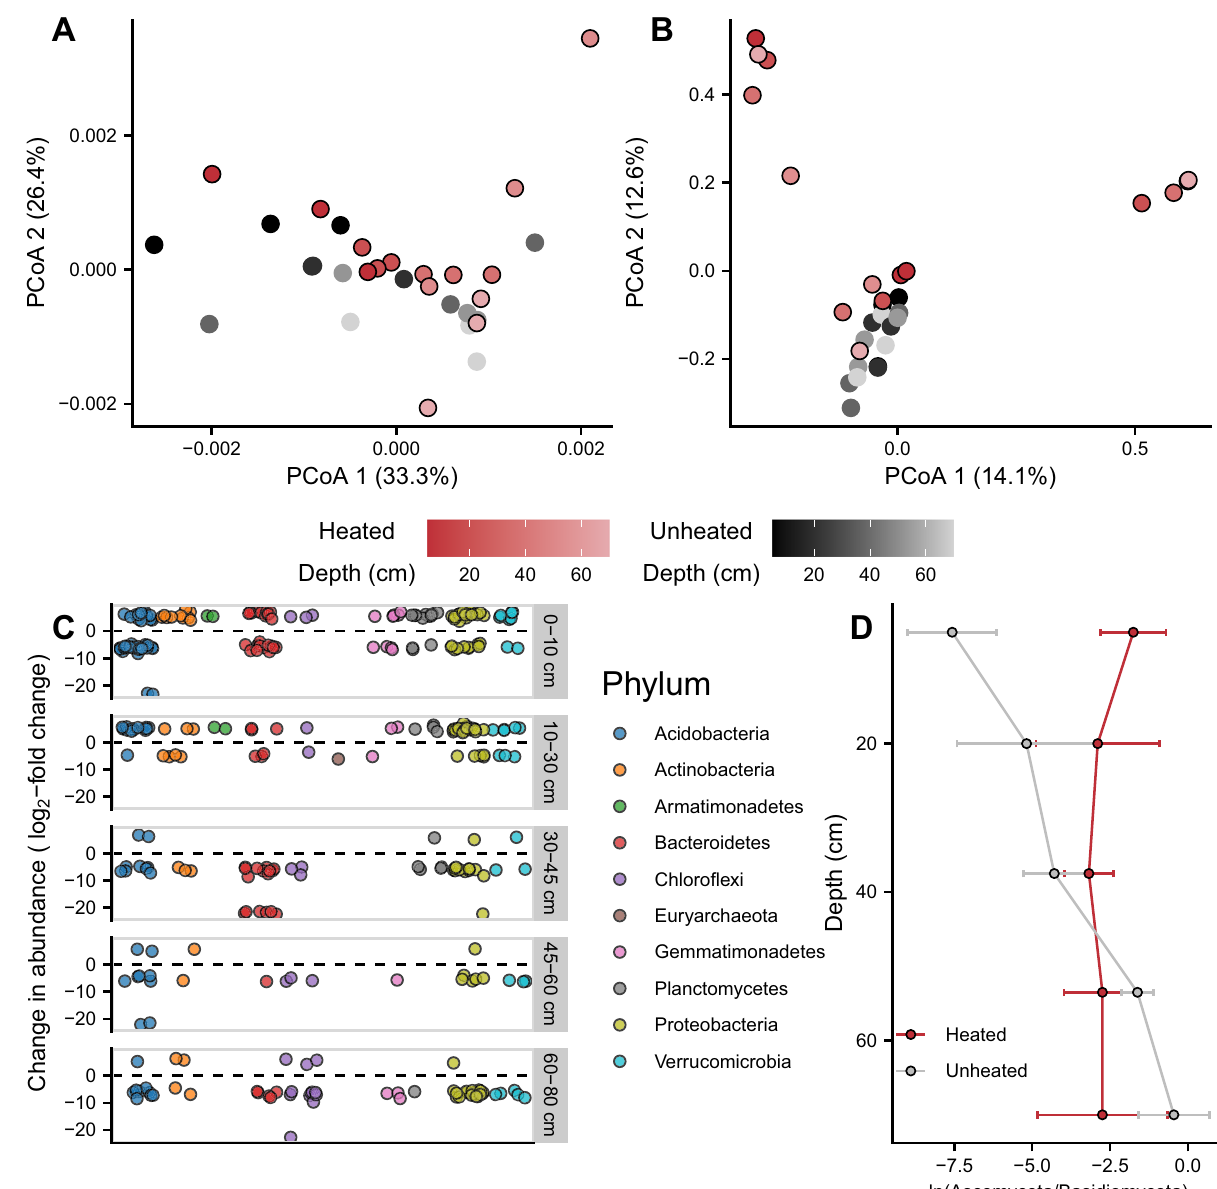
Fig. 3 Microbial communities change with heating and depth. Ordinations of microbial communities using Principal Coordinates Analysis (PCoA) for prokaryotes ( A ) and fungi ( B ). Points denote individual samples. Red colors show heated plots and black colors show unheated control plots. Saturated colors show upper depths and unsaturated colors show deeper depths. Prokaryote operational taxonomic units with signi fi cant changes in abundance by soil heating (Wald test: p < 0.05) are shown by phylum and across depths ( C ). Relative abundances of fungal phyla (i.e., Ascomycota to Basidiomycota ratios) are shown for heated (red) and unheated (gray) soils ( D ). Error bars show ±one standard error ( n =